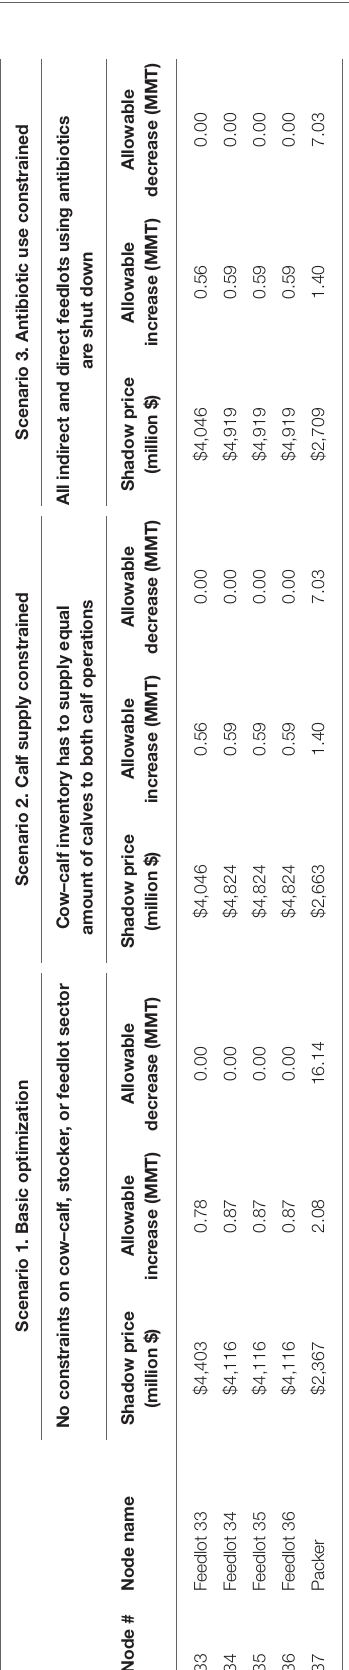
($611 per head) in feedlots using metaphylaxis and